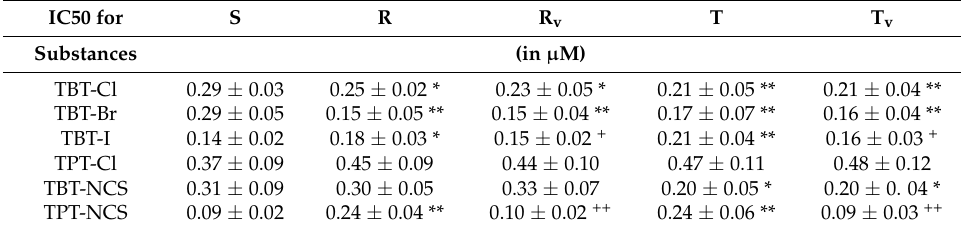
Table 2. The IC 50 values for the growth inhibition of S, R and T cells by triorganotin derivatives. IC50 for